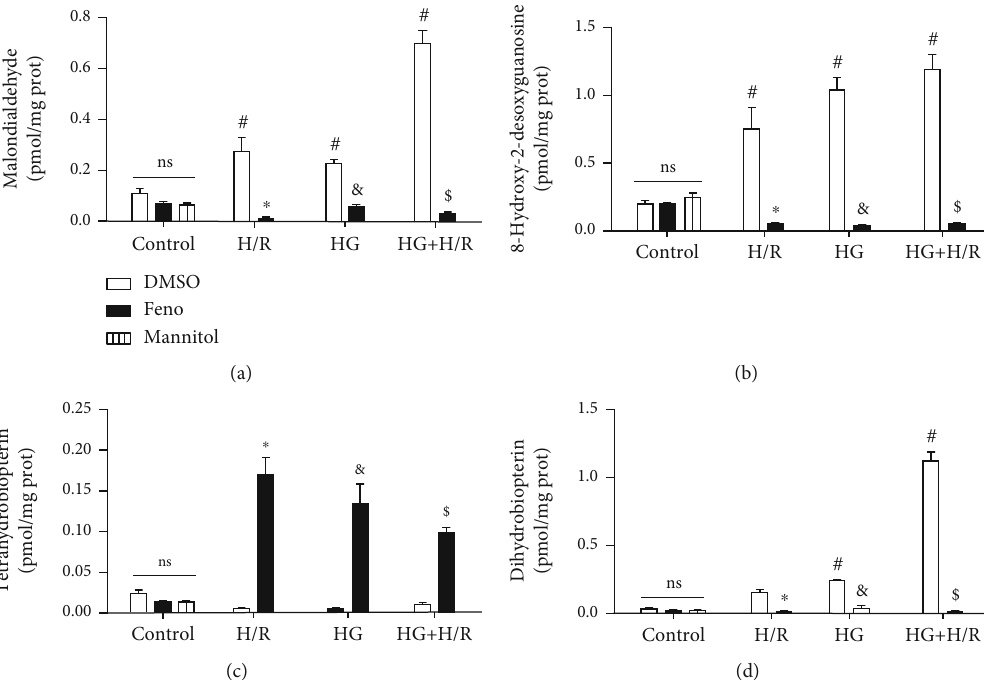
Figure 7: Feno fi brate (10 μ M) decreased the production of oxidant markers and prevented BH cardiomyocytes undergoing hypoxia/reperfusion (H/R), high glucose (HG), and HG+H/R. (a) Malondialdehyde, (b) 8-hydroxy-2- deoxyguanosine, (c) BH , and (d) BH levels were measured by capillary zone electrophoresis. DMSO = dimethylsulfoxide (0.1%); Feno = 4 2 feno fi brate (10 μ M). # p < 0 : 05 vs. control-DMSO; ∗ p < 0 : 05 vs. H/R-DMSO; & p < 0 : 05 vs. HG-DMSO; $ p < 0 : 05 vs. HG+H/R-DMSO. Values represent the mean ± SEM of 6 di ff erent experiments. Two-way analysis of variance (ANOVA) followed by Tukey ’ s post hoc